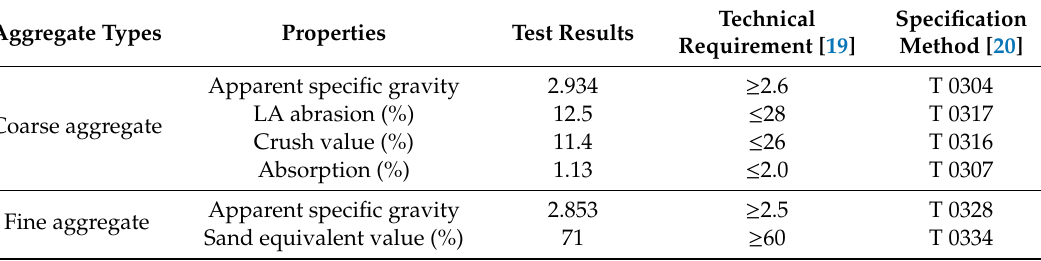
Table 2. Properties of